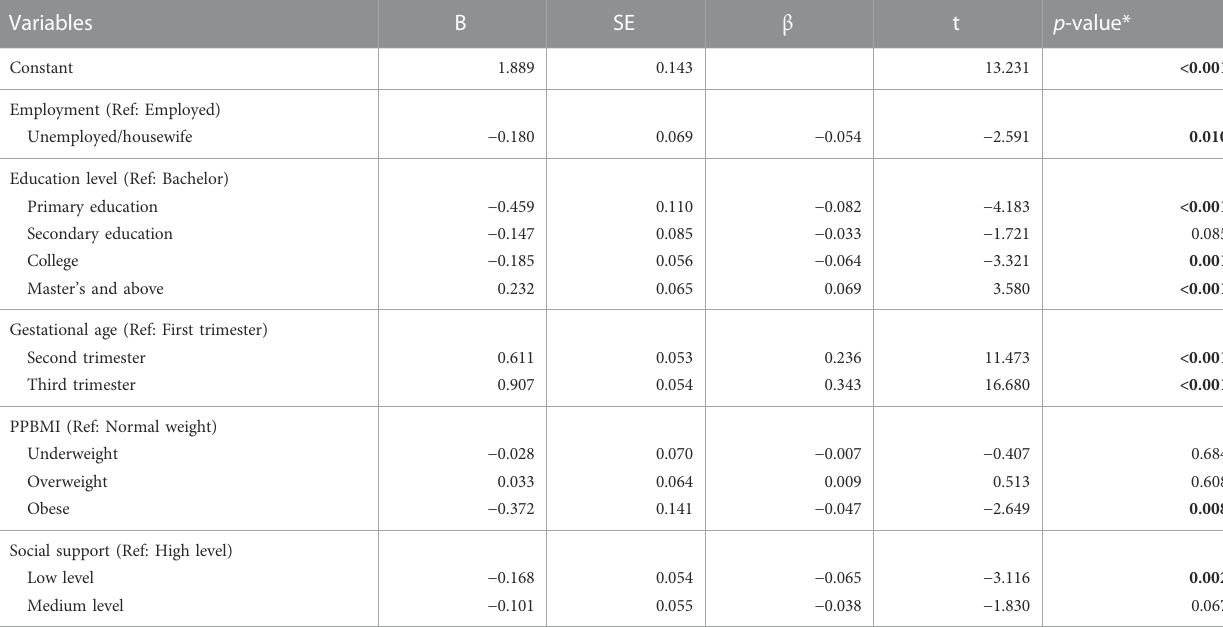
TABLE 4 Multivariable analysis of factors related to the number of different dietary supplements used by pregnant women.